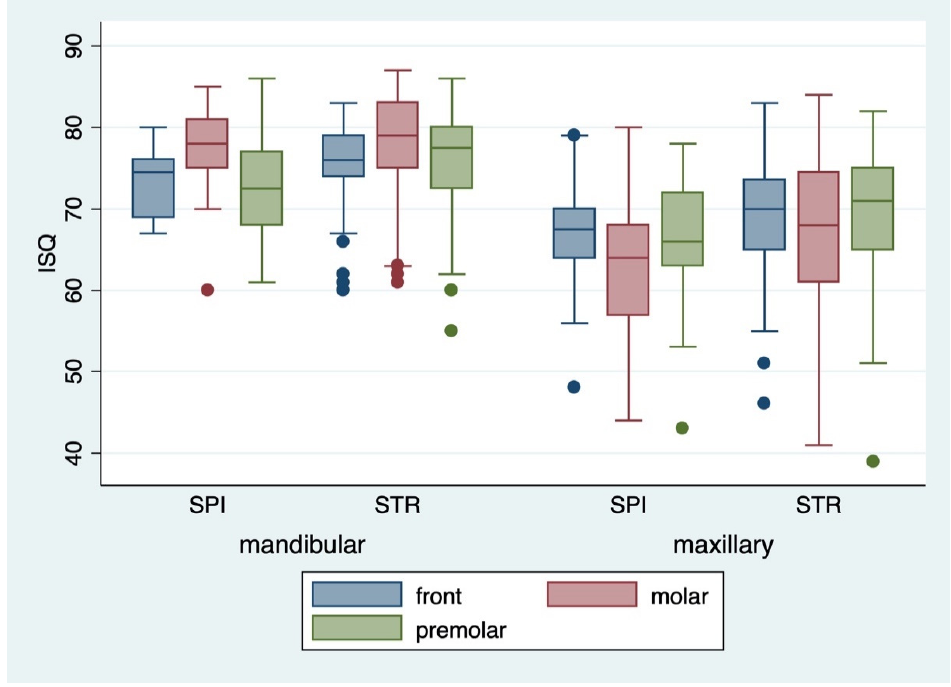
Figure 3. Boxplots showing ISQ values at insertion stratified by implant system and localizations. STR: Straumann implants. SPI: Thommen implants. ISQ: implant stability quotient.